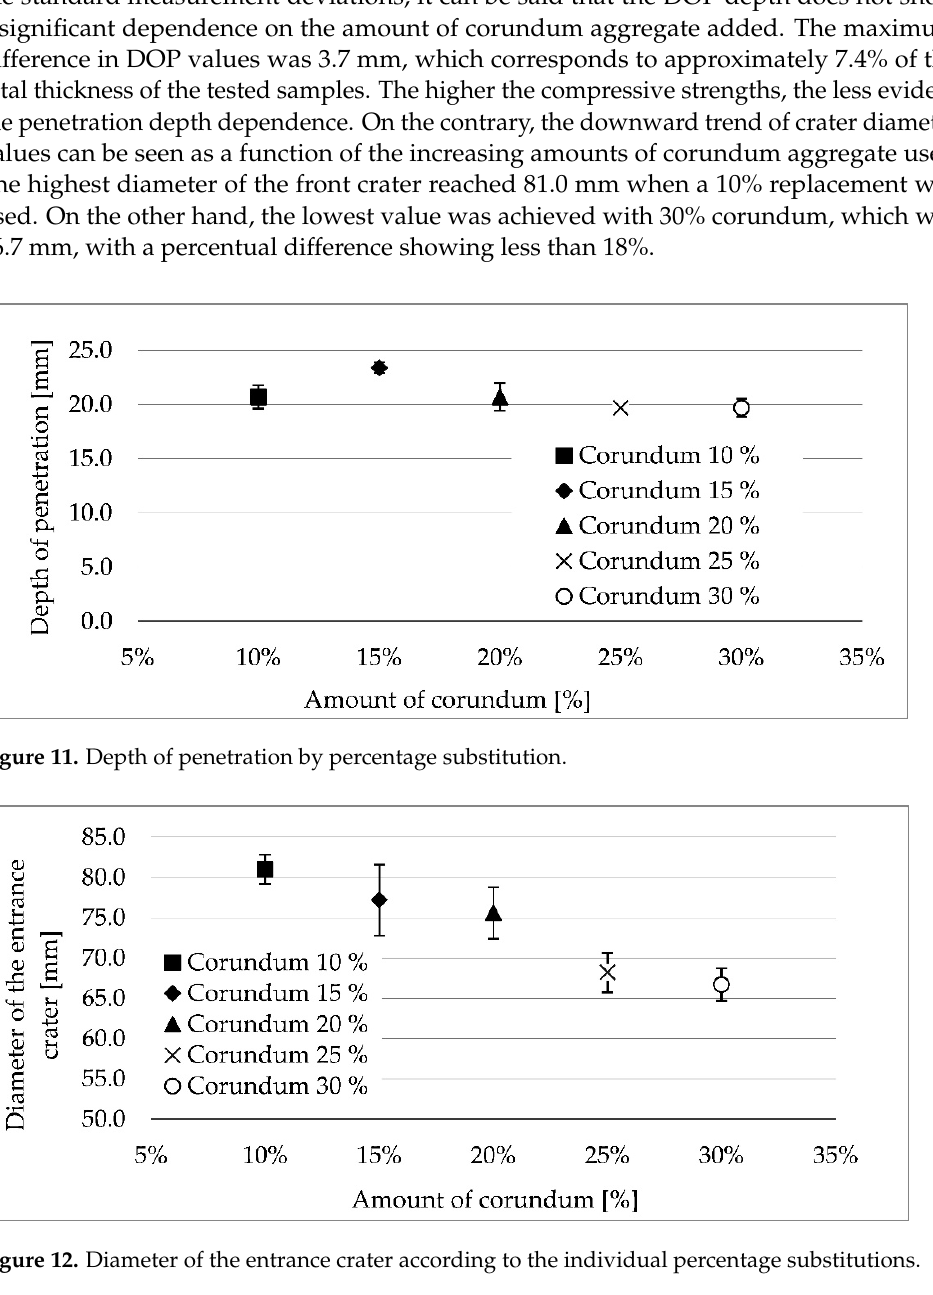
Figure 13. Size of the entrance crater area according to individual percentage substitutions. Figure 14. Rear side crater area by percentage substitution.